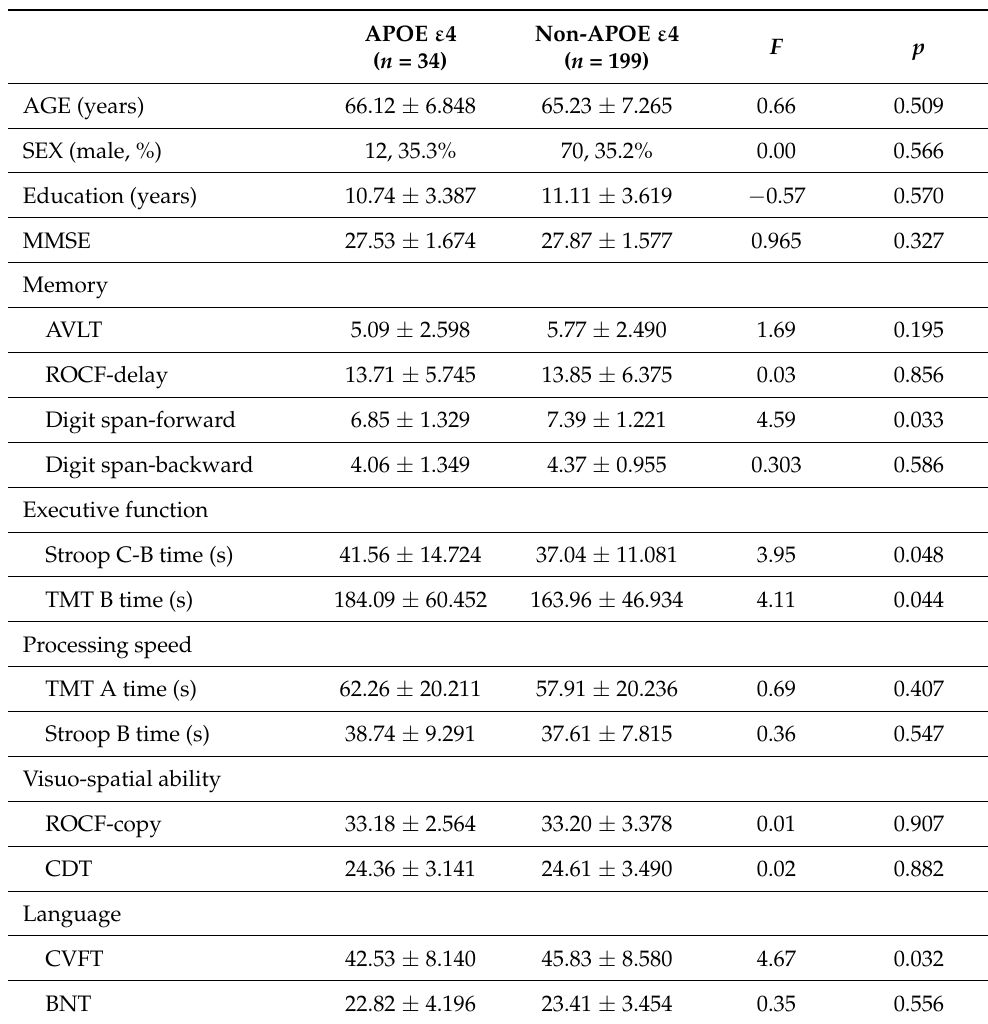
Table 1. Characteristics and neuropsychologic test results of participants in large sample from Beijing